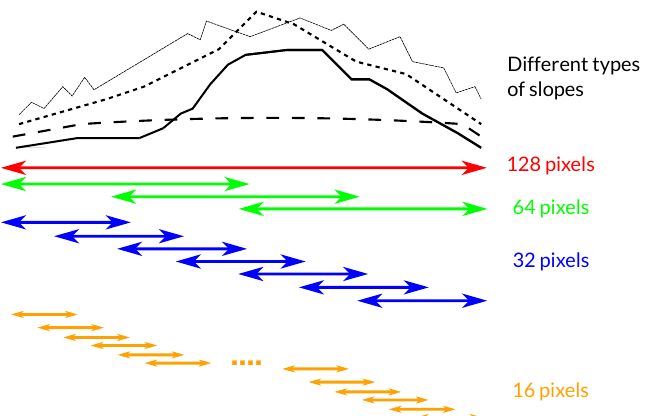
Figure 6. Representation of the proposed multi-scale range-filtering algorithm. An overlapping factor of 50% is